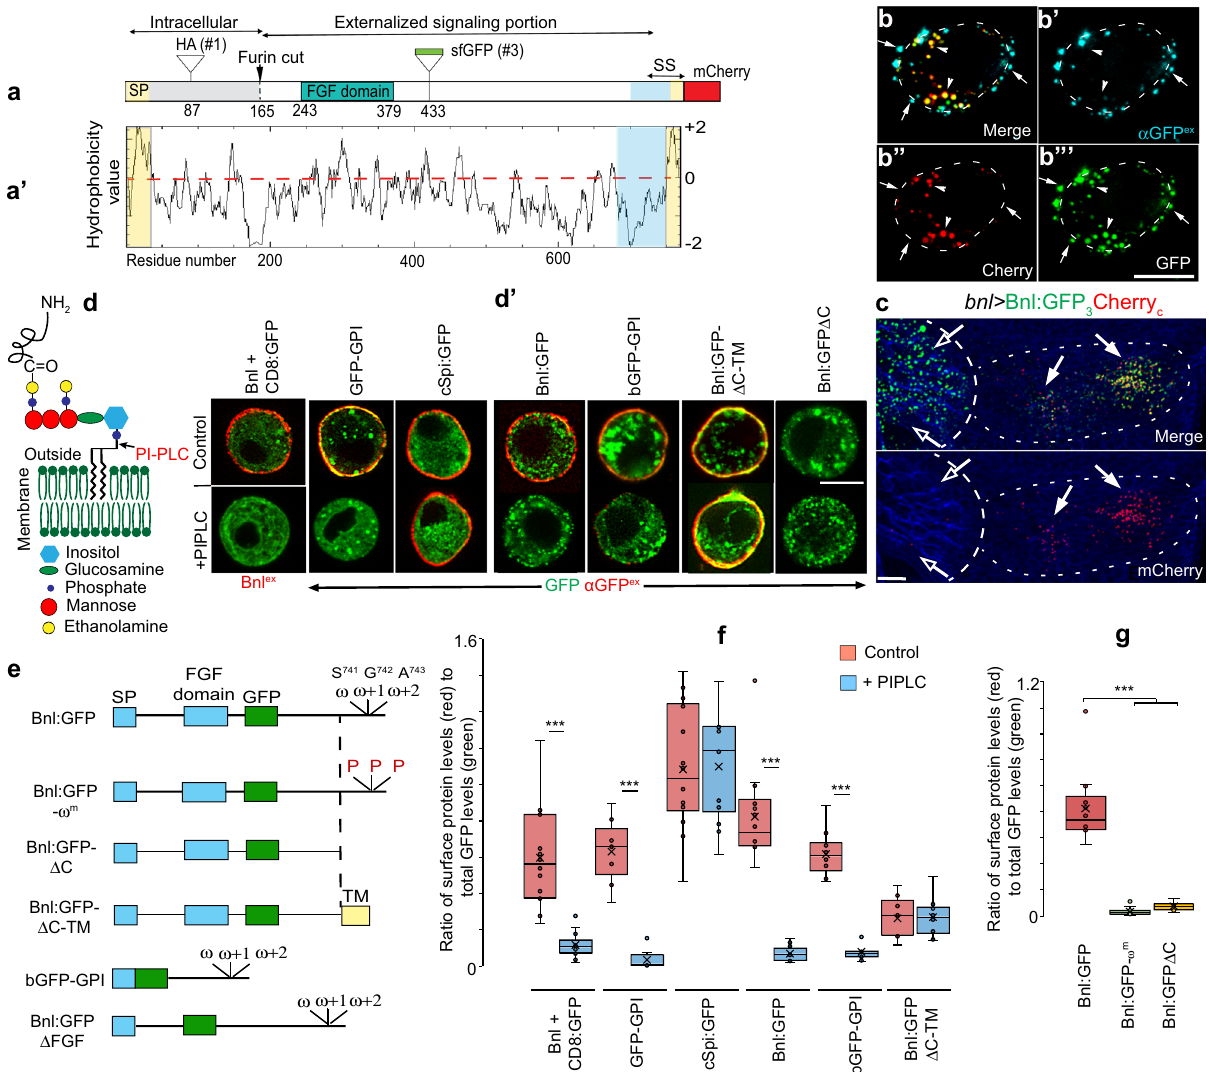
Fig. 4 Post-translational cleavage and lipidation of Bnl. a , a ’ Schematic map of the Bnl protein ( a ) and hydrophobicity plot ( a ’ ); SP, signal peptide; conserved FGF-domain, HSPG + FGFR binding sites; arrow, furin cleavage site; sites for HA- (site #1), GFP- (site # 3), and mCherry- tags and putative signal sequence (SS; hydrophilic spacer — blue; hydrophobic tail — yellow). b – b ”’ Representative optical sections of S2 cells expressing Bnl:GFP 3 Cherry c ; arrowheads, uncleaved intracellular protein; arrow, cleaved externalized Bnl:GFP 3 ex portion probed with α GFP ex (blue); dashed line, cell outline; split channels — as indicated. c Wing disc expressing Bnl:GFP 3 Cherry c under bnl-Gal4 ; arrow, intact protein harboring GFP and mCherry; open arrow, cleaved Bnl:GFP 3 ; long and short dashed line, ASP and bnl- source, respectively; blue, α Dlg. d Illustration of a GPI-AP and the PI-PLC cleavage site. d ’ – g PI-PLC- mediated cell-surface shedding of various constructs expressed from S2 cells. e Schematic maps of the Bnl variants used. d ’ red, surface-localized fraction of either GFP-tagged proteins ( α GFP ex immunostaining) or Bnl ( α Bnl ex immunostaining) in expressing cells. f , g Box plots comparing the ratio of cell surface (red, α GFP ex or α Bnl ex immuno fl uorescence) to total proteins (GFP fl uorescence) in cells with and without PI-PLC treatment; for untagged Bnl, the surface Bnl level was normalized with co-expressed CD8:GFP; box shows the median and 1st and 3rd quartile, and whiskers are minimum and maximum. *** p < 0.001 (unpaired two-tailed t test). f Number of cells/condition ( n ): Bnl + CD8:GFP control and PI-PLC (14); GFP-GPI — control (9) & PI-PLC (8); cSpi:GFP — control (14) and PI-PLC (14); Bnl:GFP — control (14) & PI-PLC (12); bGFP-GPI — control (13) & PI-PLC (11); Bnl:GFP Δ C-TM — control (9) & PI-PLC (10). g Number of cells analyzed (n): Bnl:GFP (14), Bnl:GFP- ω m (16), and Bnl:GFP Δ C (9). S2 cells: co-transfected with actin-Gal4 and UAS- “ X ” . Source data are provided as a Source data fi le. Scale bars: 10 μ